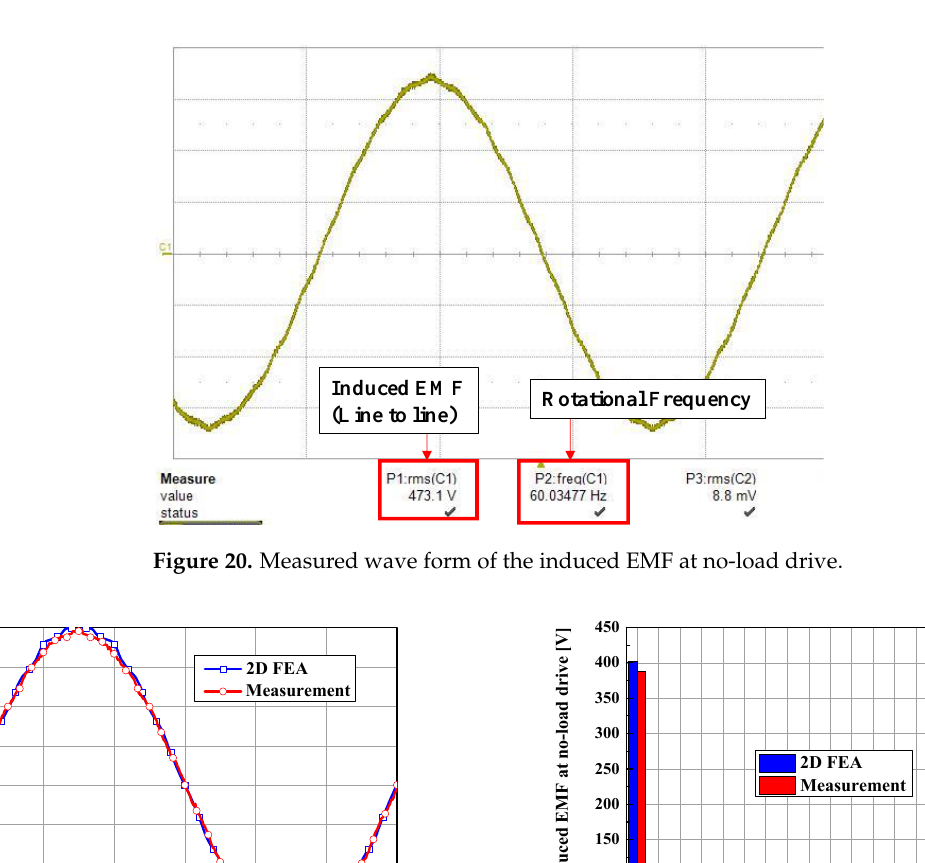
Figure 21. Comparison of 2D FEA and measurement results: ( a ) wave form, and ( b ) harmonic order. Table 6. Phase fundamental component and THD at the no-load drive for the results of 2D FEA and